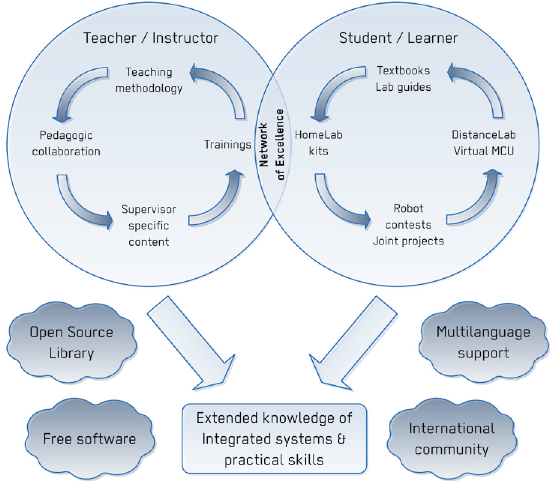
Figure 1. The Robotic Teaching and Learning